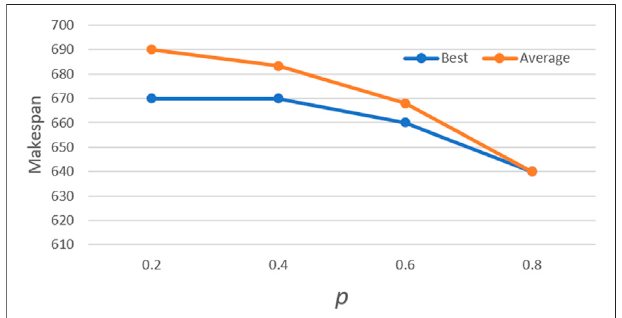
FIGURE 6 | Trend of